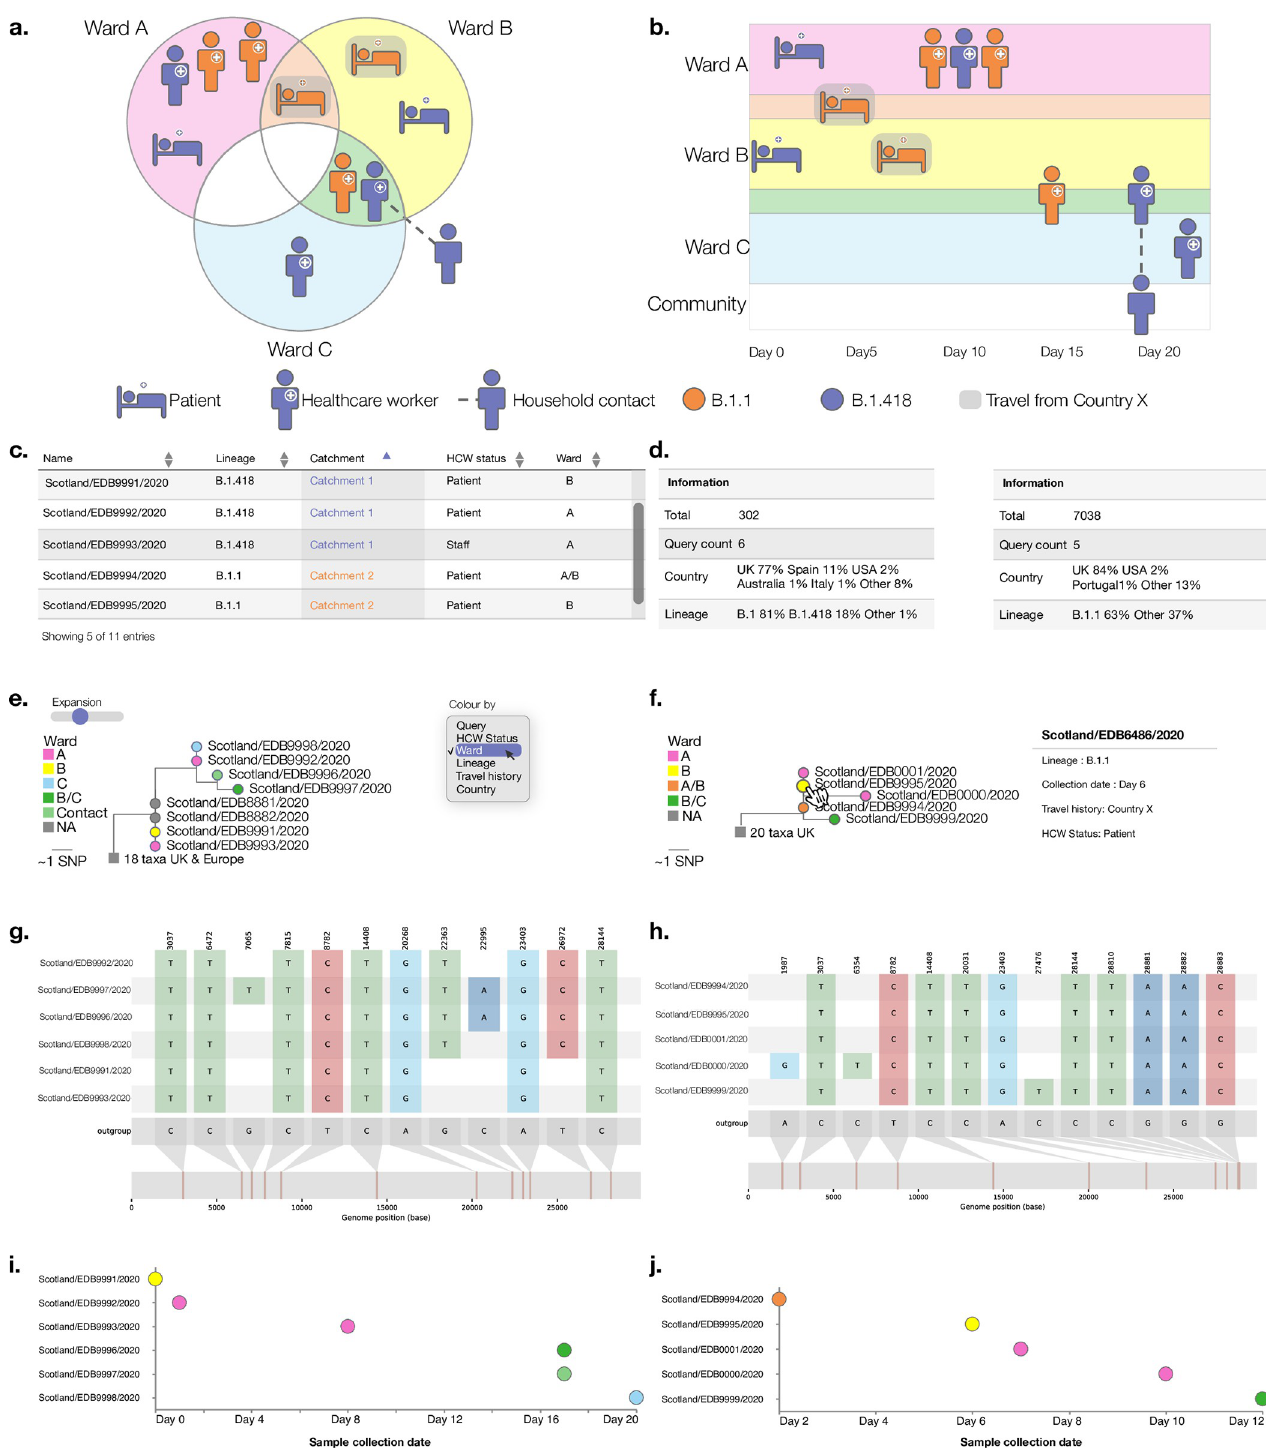
Fig 3. Schema of clinical outbreak investigation June 2020, colour of cases indicate lineage revealed by genome sequencing (B.1.1 or B.1.418) (a-b) and components of a civet report generated for the outbreak investigation (c-j). a) The outbreak occurred across three wards and involved six members of staff, four patients and one household contact of a staff member. b) Timeline of sample collection dates across wards A, B and C. c) The metadata of all query sequences is summarised in an interactive table, with sortable columns that can be toggled on and off. d) Each catchment is summarised in full, regardless of downsampling. Number of queries and the countries and lineages within the catchment are indicated. e) The catchment phylogenies are displayed initially in compact form,